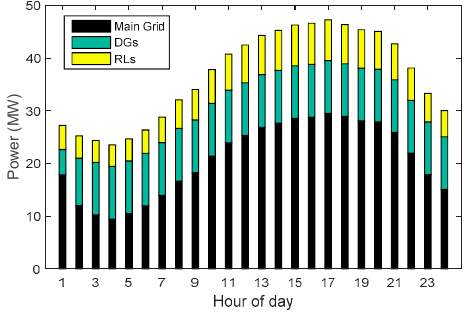
Figure 6. Energy resources scheduling results for Case 2.